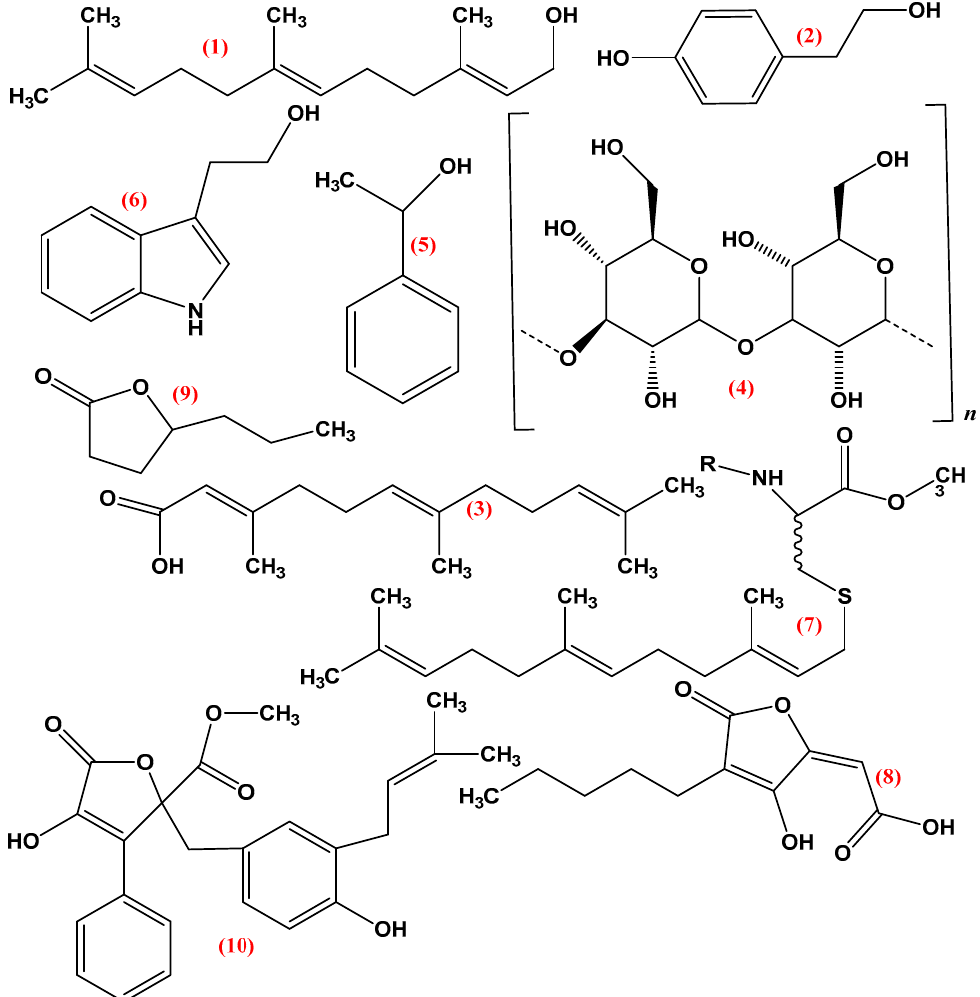
Figure 4. Chemical structure of various fungal quorum sensing molecules (1) Farnesol, (2) Tyrosol, (3) Farnesoic acid, (4) α -(1,3)-glucan, (5) 1-Phenyl-ethanol, (6) Tryptophol, (7) Pheromones 1. a-factor 2. α -factor, (8) Multicolanic acid, (9) γ -Heptalactone, (10) Butyrolactone-I.